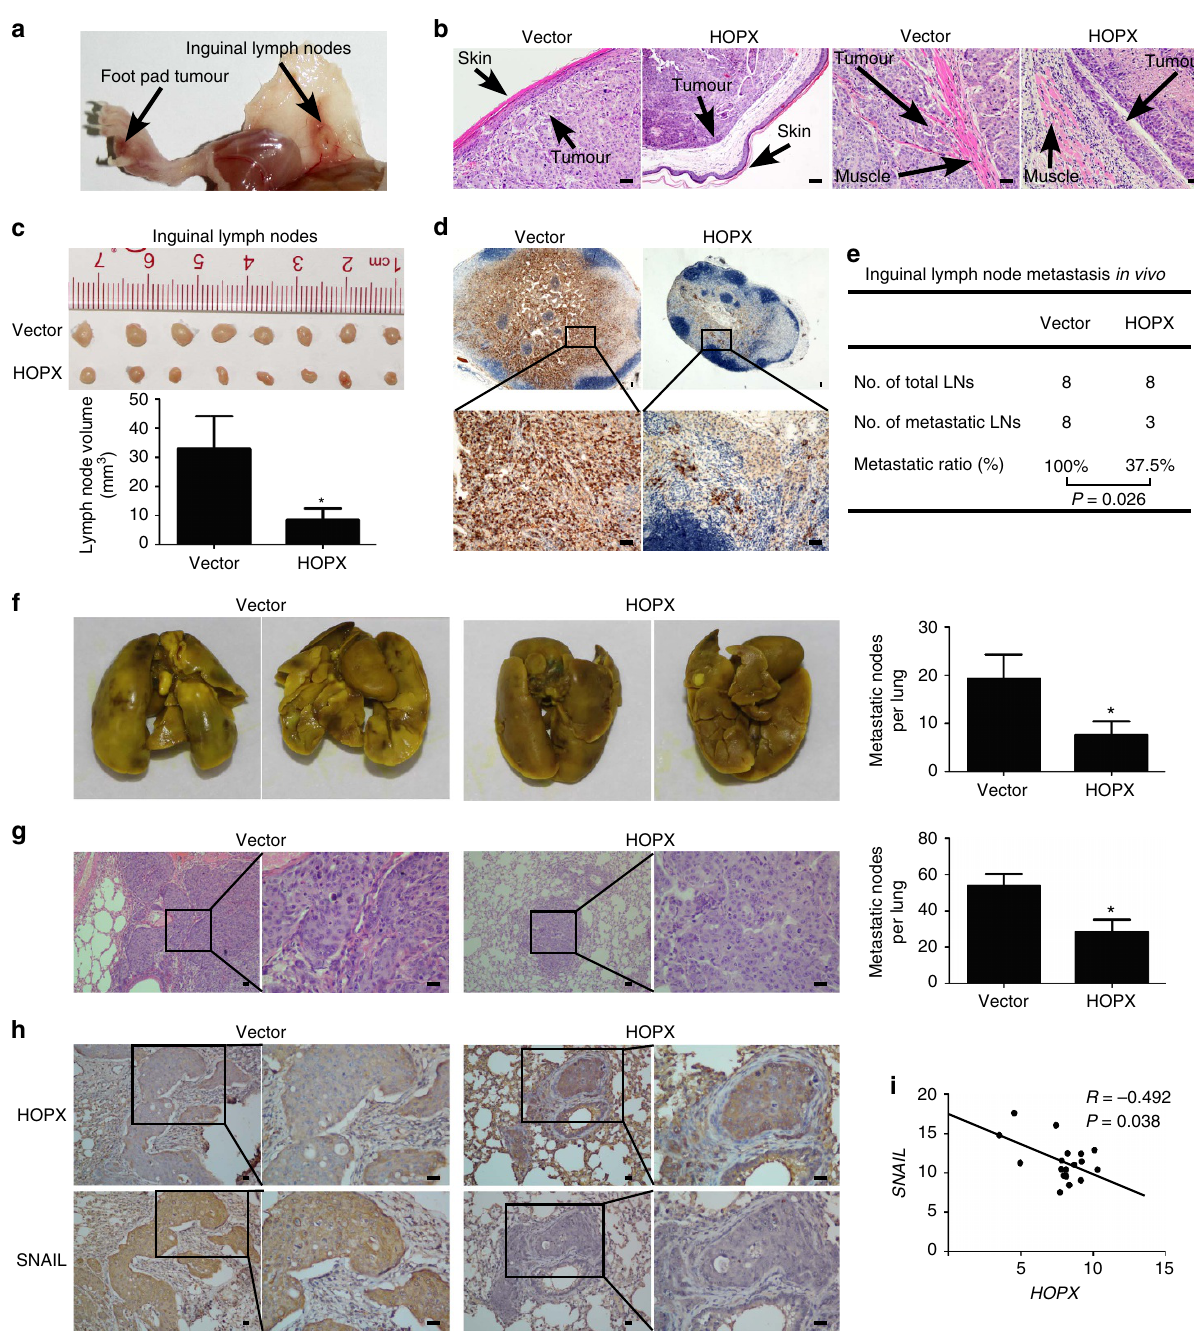
Figure 8 | HOPX restoration inhibits NPC cell aggressiveness and SNAIL expression in vivo . ( a – e ) SUNE1 cells stably overexpressed the vector or HOPX ( n ¼ 8 per group) were injected into the foot pads of mice to construct inguinal lymph node metastasis models. ( a ) Representative images of primary foot pad tumour and metastatic inguinal lymph node. ( b ) Representative images ( (cid:2) 200) of microscopic primary tumours in foot pads stained with haematoxylin and eosin (H&E). Scale bar, 100 m m. ( c ) Representative images and quantification of the average volumes of the inguinal lymph nodes. Mean ± s.d.; * P o 0.01 compared with vector; Student’s t -tests. ( d ) Immunohistochemical staining for pan-cytokeratin-positive tumour cells in inguinal lymph nodes ( (cid:2) 40 and (cid:2) 200). Scale bar, 100 m m. ( e ) Metastatic ratios of inguinal lymph nodes; Chi-square test was used for statistical analysis. ( f – h ) SUNE1 cells with vector or HOPX overexpression group ( n ¼ 5 per group) were injected into the tail veins of mice to construct a lung colonization model. ( f ) Representative images of macroscopic tumour colonization and growth in lung tissues and the number of tumour nodules in mice xenograft. Mean ± s.d.; * P o 0.01 compared with vector; Student’s t -tests. ( g ) Representative images ( (cid:2) 100 and (cid:2) 400) and quantification of the average number of microscopic tumour nodes in lungs stained with H&E. Scale bar, 100 m m; mean ± s.d.; * P o 0.01 compared with vector; Student’s t -tests. ( h ) Immunohistochemical staining for HOPX and SNAIL expression in the lungs of mice xenograft ( (cid:2) 100 and (cid:2) 400). Scale bar, 100 m m. ( i ) Relative HOPX and SNAIL expression values were determined via real-time RT–PCR in the NPC tissues ( n ¼ 24). Statistical analysis was performed using the Pearson’s coefficient test. Each mouse sample was considered as an independent experiment; three technological replications were repeated in each